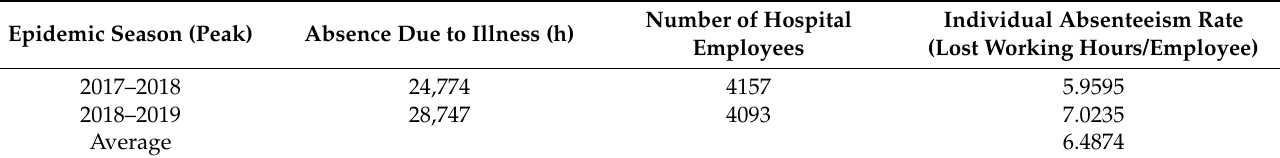
Table 3. Absence due to illness among the hospital staff during the peaks of the 2017–2018 and 2018–2019 flu seasons.